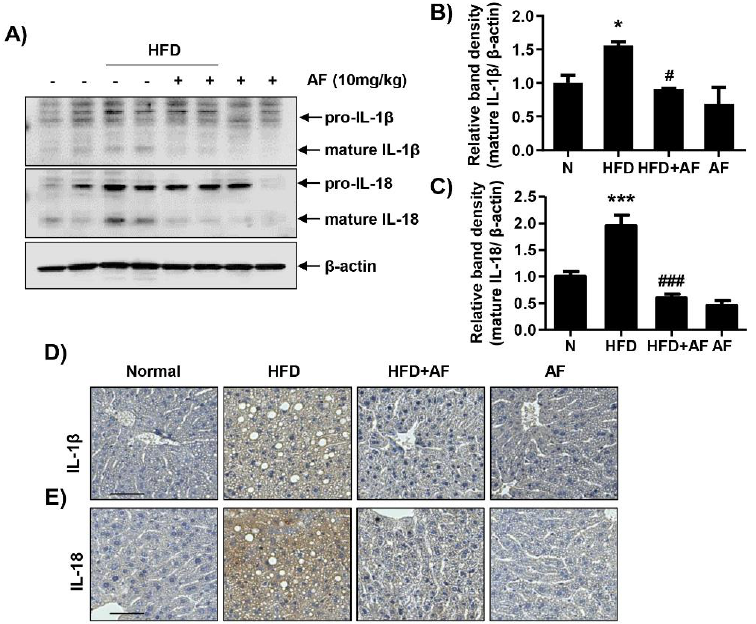
Figure 4. Auranofin ameliorates interleukin (IL) 1-β and IL-18 expression and secretion in the liver and serum of the HFD-induced NAFLD mouse model. Following treatment with or without HFD and auranofin for 8 weeks, the liver tissues were obtained. ( A ) Liver (300 μg) was homogenized with 500 μL of lysis buffer supplemented with protease and phosphatase inhibitors. Western blots showing levels of IL-1β and IL-18 in the mouse liver in each group. Quantification of IL-1β ( B ) and IL-18 ( C ) expression. Data are expressed as means ± SD ( n = 4). * p < 0.05 and *** p < 0.001 compared with the normal group. # p < 0.05 and ### p < 0.001 compared with HFD group. The hepatic expression of IL-1β ( D ) and IL-18 ( E ) protein were assessed by immunohistochemistry analysis ( n = 3). Scale bar—50 μm. N, normal group; HFD, HFD fed group; HFD+AF, HFD fed and auranofin injection group; AF, auranofin injection group.